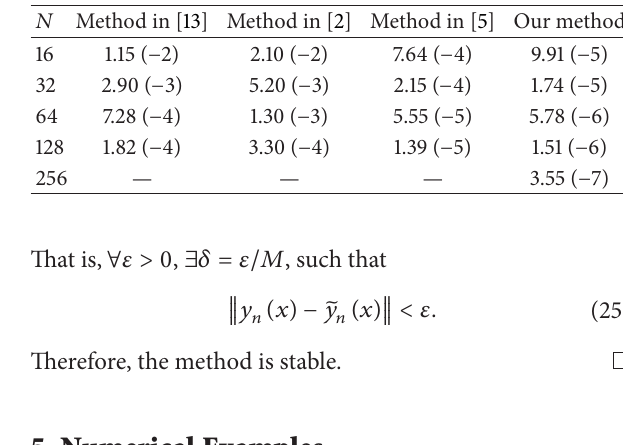
Table 1: The M.A. error of Example